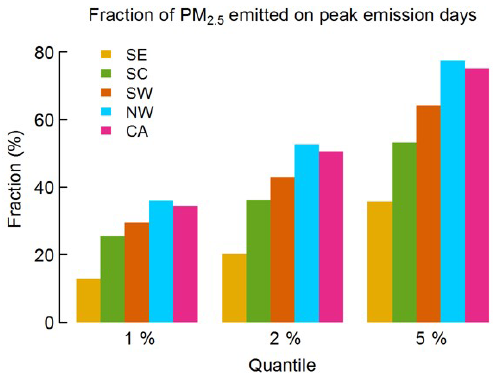
Figure 17. Cumulative distribution of daily PM 2 . 5 emissions ag- gregated on a 10km × 10km grid. The dashed line and dashed– dotted line mark 5% and 10% of grid cell days with